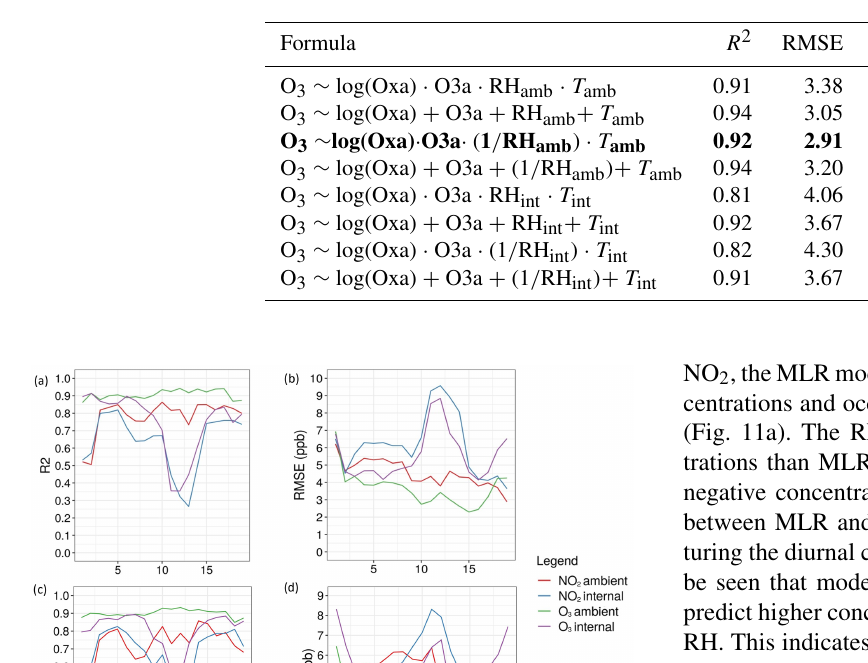
Table 3. Results of the MLR model selection process for O 3 . The most accurate model is in bold. RMSE and MAE are in units of parts per billion.